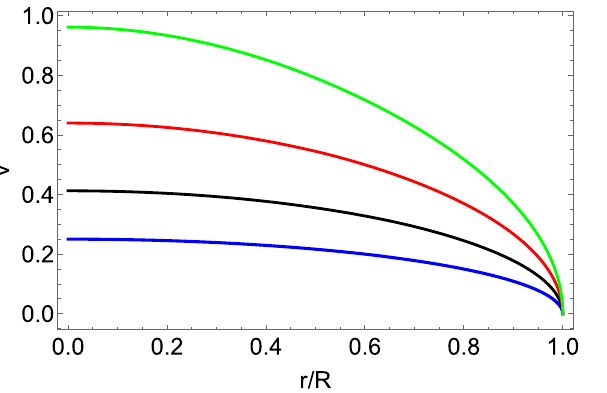
Fig. 7 Δ E for u = 0 . 1 (blue line), u = 0 . 15 (black line), u = 0 . 2 (red line), u = 0 . 3 (green line), u = 0 . 37 (yellow line) and (cid:13) =